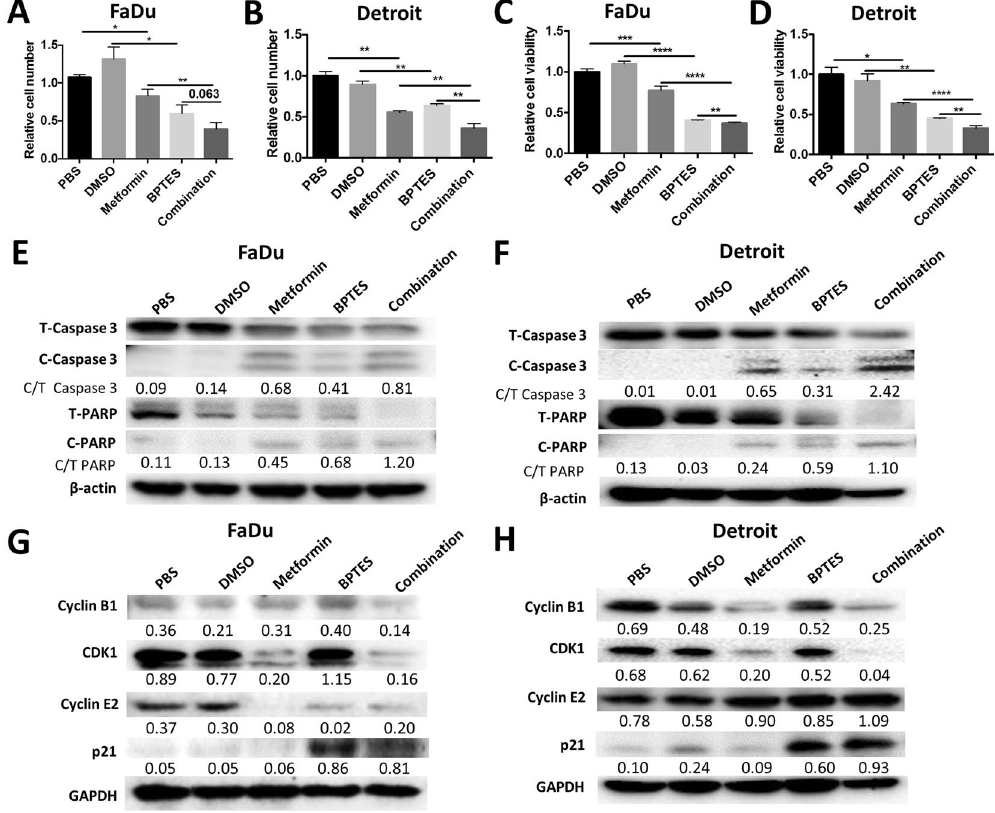
Figure 5. Combined treatment of BPTES and metformin additively inhibits the cell viability of HNSCC. 10,000 of FaDu or Detroit cells were seeded in 96-well plate and treated with BPTES (20 μ M) or metformin (10 mM) or the combination for 48 hours. The cell numbers of FaDu ( A ) and Detroit ( B ) cell lines were determined by crystal violet staining. The viability of FaDu ( C ) and Detroit ( D ) cells was determined by MTT assay. Apoptotic markers of FaDu ( E ) and Detroit ( F ) cells t were determined by western blotting. β -actin was used as internal control. The ratio of cleaved Caspase 3 to total Casepase 3 (C/T Caspase 3), or cleaved PARP to total PARP (C/T PARP) was displayed under the band of indicated treatments. Cell cycle regulatory proteins in FaDu ( G ) and Detroit ( H ) cells were determined by western blotting with GAPDH used as internal control. The ratio of indicated protein to internal control was displayed under each band. * p < 0.05, ** p < 0.01, *** p < 0.001,